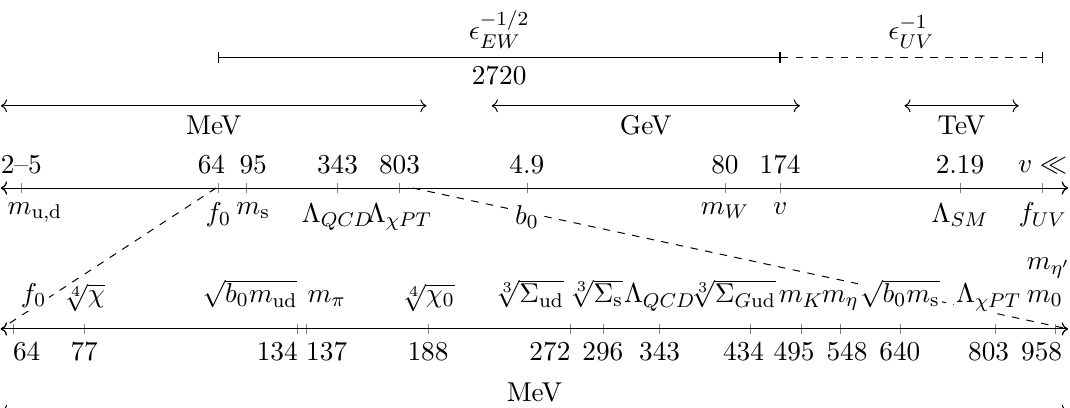
Figure 9. Illustration of the energy scales appearing in portal χ PT. The numeric values correspond to the central values, for simplicity we omit all